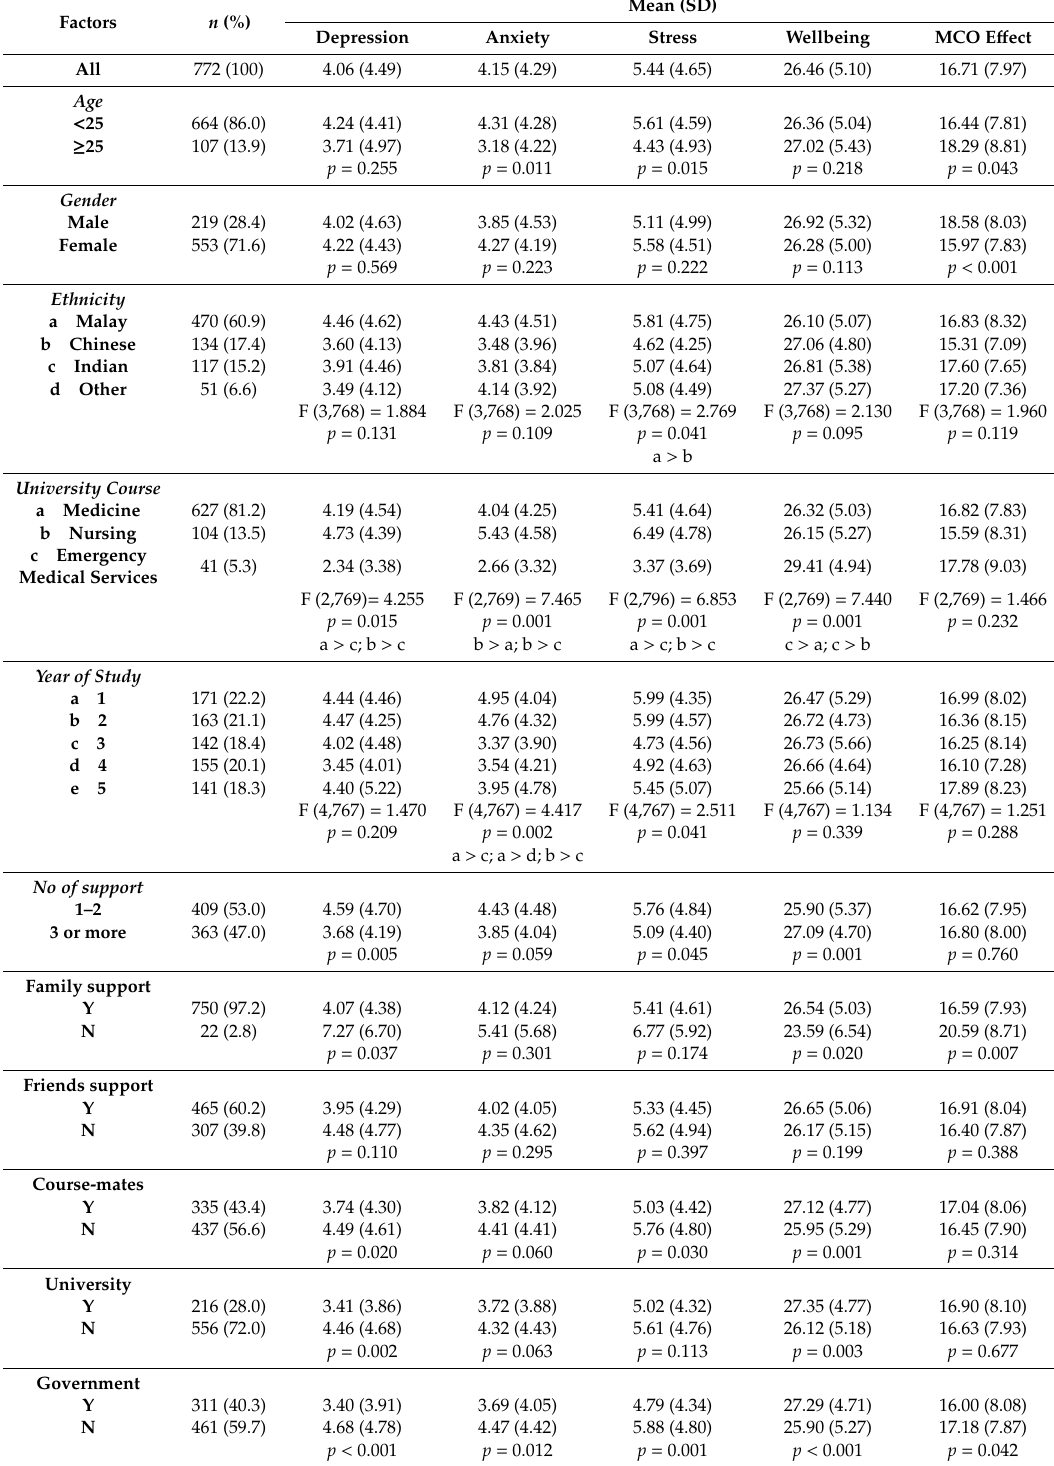
Table 1. Comparison of mean scores based on demographics, university course, and social